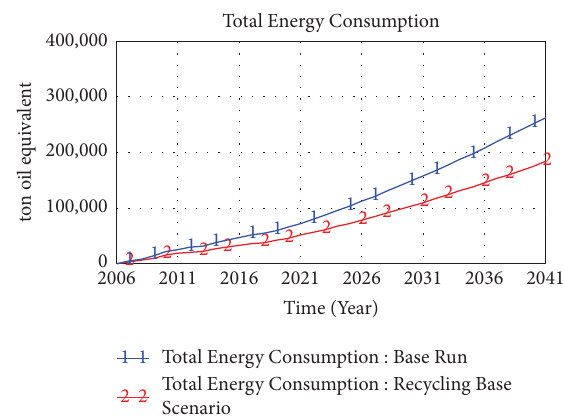
Figure 10: Comparison of the variable trend of the total energy consumption for both options.